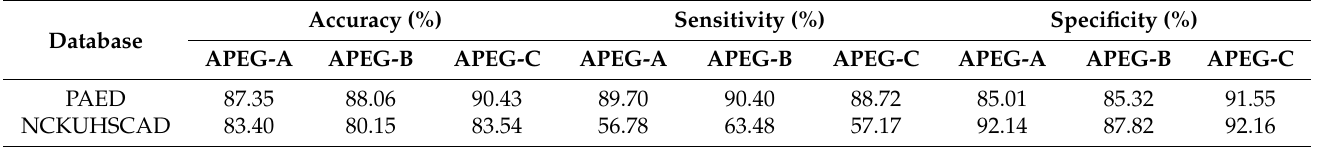
Table 3. Nested five-fold cross-validation training and validation performance using a 60 s time